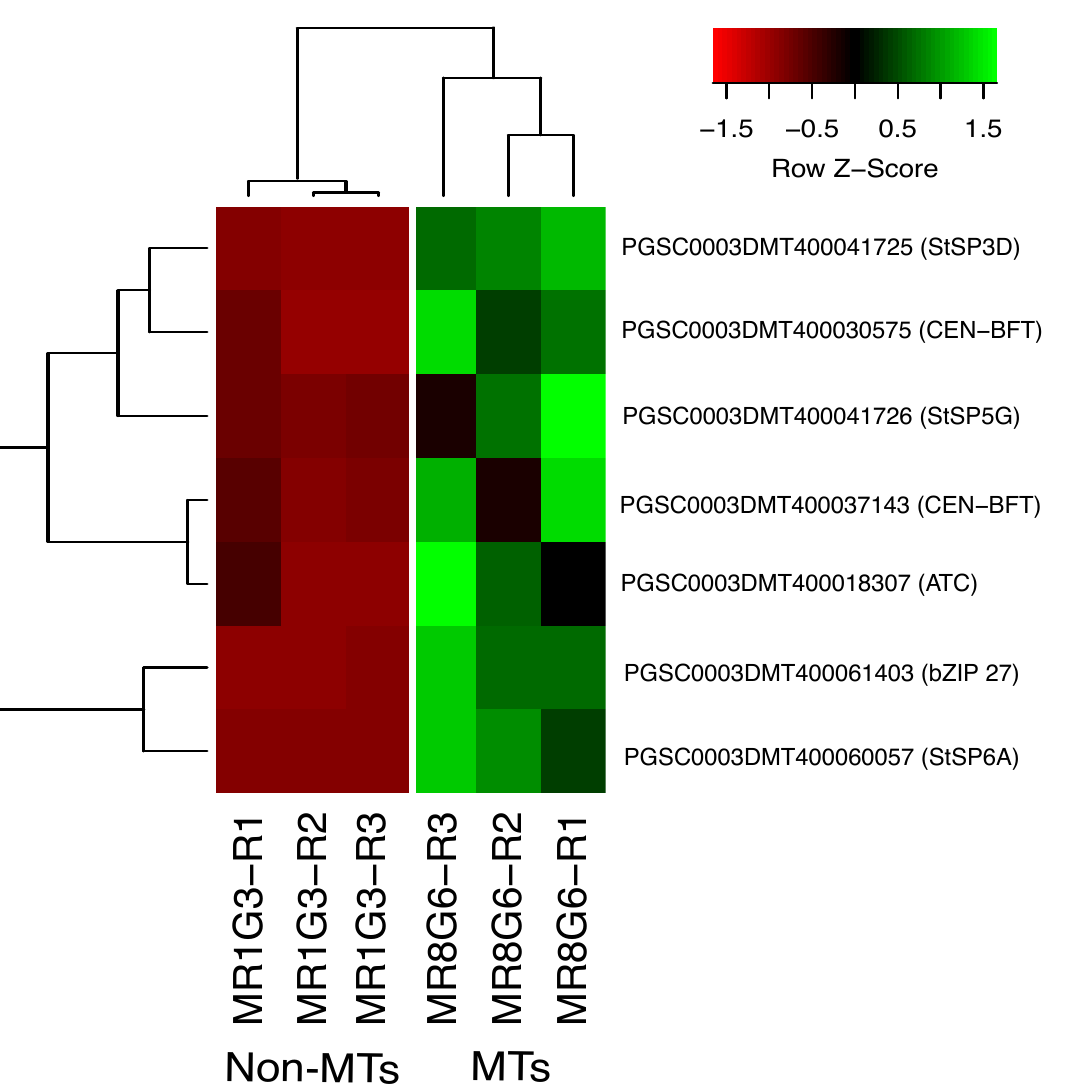
Figure 9. Hierarchical clustering analyses (HCA) and heat map of PEBP family members during MTs development under darks conditions; levels of up-regulation are present in